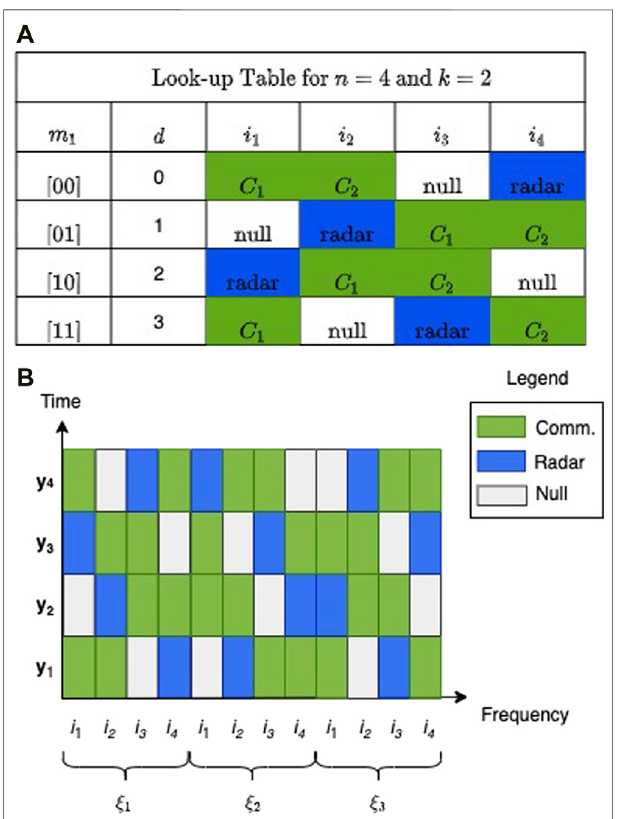
FIGURE 2 | A case study for the proposed architecture. (A) Look-up table for two active subcarriers out of four subcarriers in a subblock. (B) Example of the transmitted OFDM-IM JCR